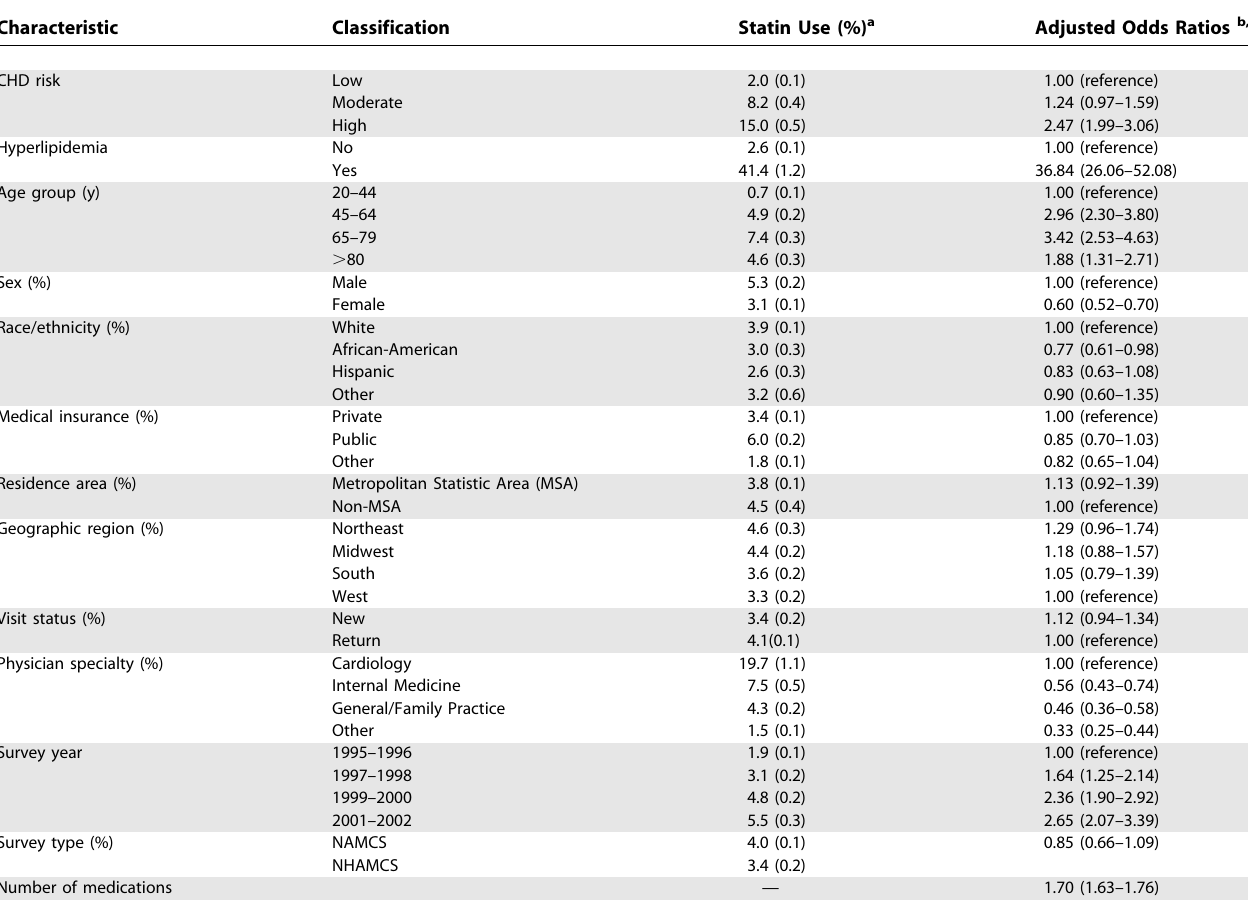
Table 2. Predictors of Statin Use with Combined 1995–2002 NAMCS and NHAMCS